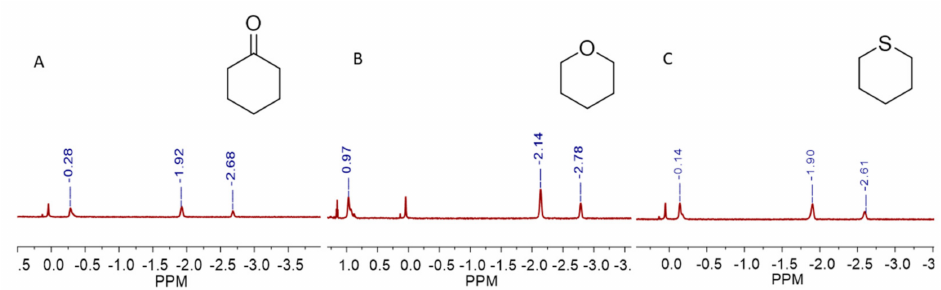
Figure 3. Partial 1 H NMR spectra of cavitand 1 upon adding from left to right ( A ): cyclohexanone, ( B ): tetrahydropyran, ( C ): thiane.